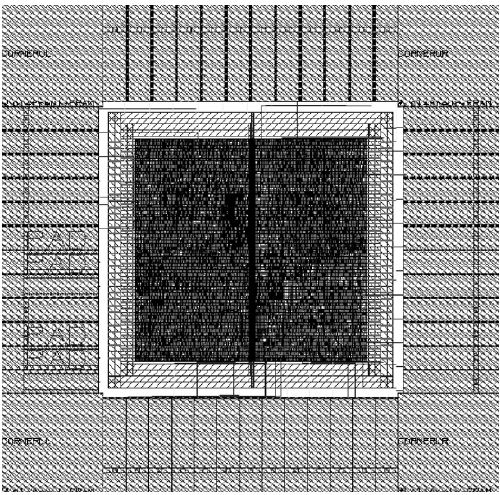
Figure 9: The layout view of the proposed signal security system implemented using 0.35 µ m CMOS technology.